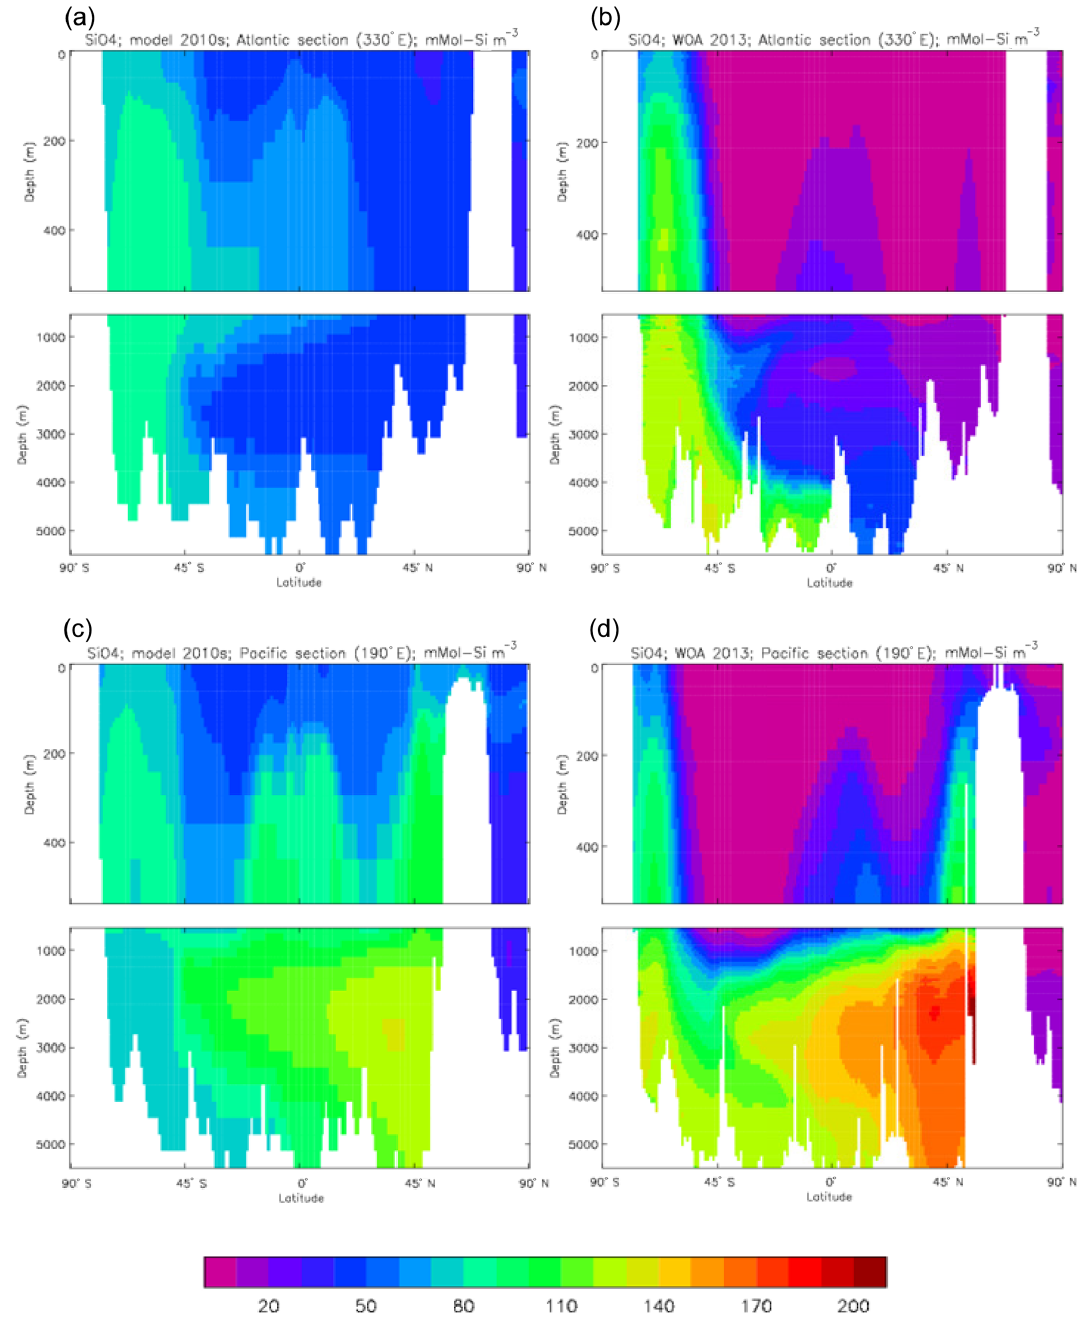
Figure 26. Meridional sections of dissolved silicate (mMolSim − 3 ): panels (a) and (b) show sections in the Atlantic Ocean along 330 ◦ ; (c, d) Pacific Ocean sections along 190 ◦ . Panels (a) and (c) show model concentrations averaged over 2010–2019; panels (b) and (d) show concentrations from the 2013 World Ocean Atlas gridded